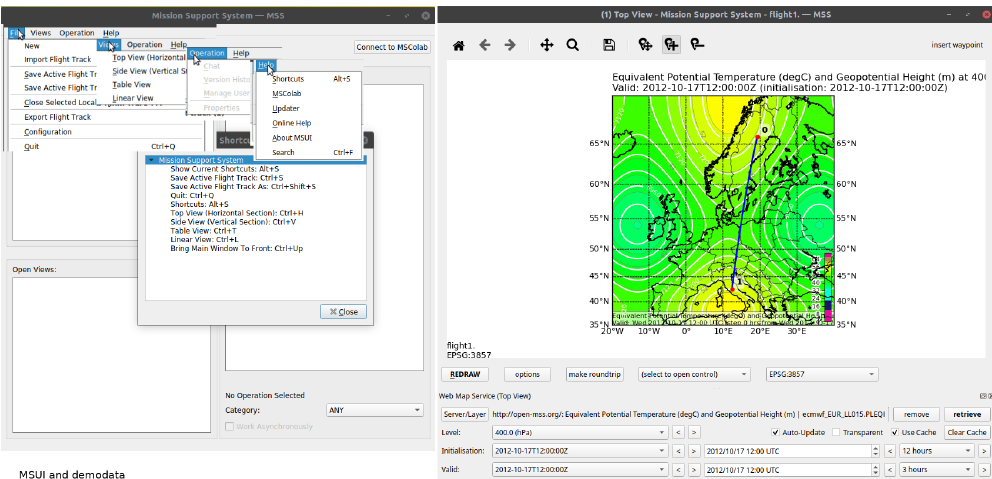
Figure 3. Main window of the